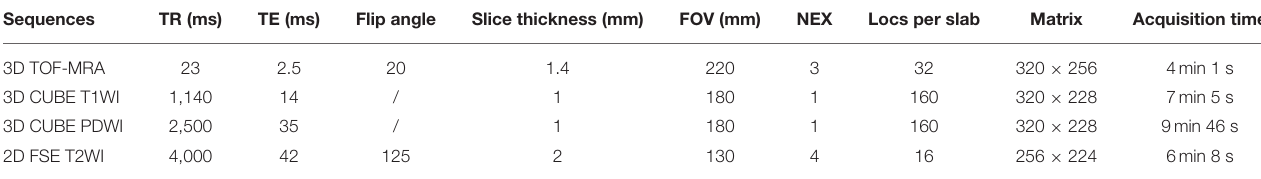
TABLE 1 | Vessel wall imaging protocol.